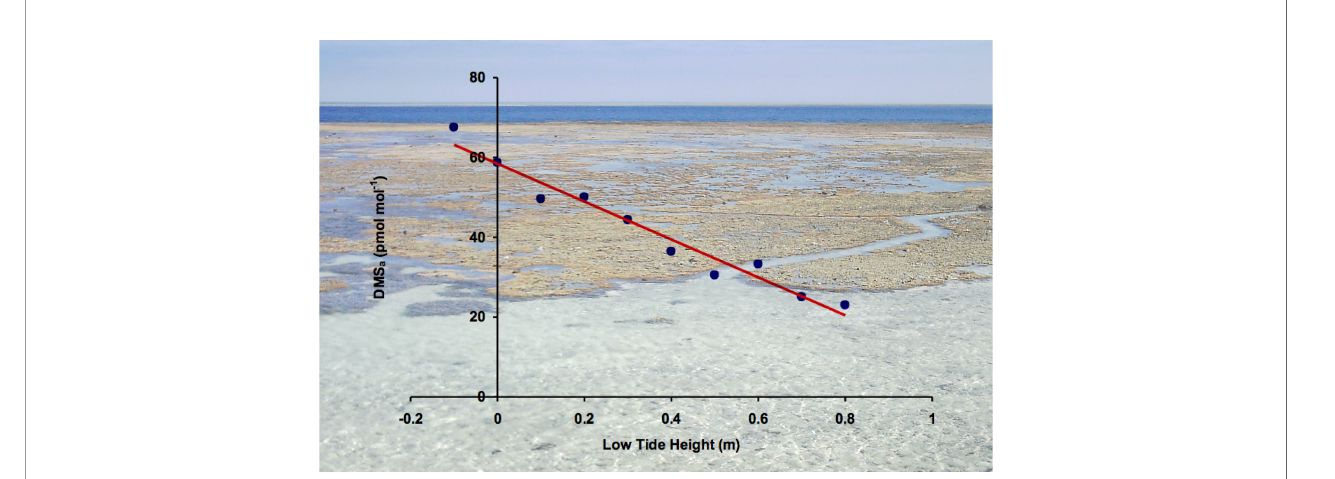
FIGURE 2 | Median atmospheric DMS mixing ratios plotted against low tide seawater height at Heron Island (23.44°S, 151.91°E) on the southern GBR, 18 Jul - 5 Aug 2013 (austral winter), derived from 30 min resolution measurements of DMS a . The plotted median values are for measurements made in a time window approximately ± 1 h either side of the low tide height range that, to varying extents, aerially exposed the 27 km 2 lagoonal platform coral reef surrounding Heron Island shown in the photo (H.B. Swan). According to the dominant south-easterly trade winds at this location, the Heron Reef and the adjacent Wistari Reef, 1 km to the south, are expected to be the sources of DMS a in excess of the approximately 20 pmol mol -1 DMS a background wintertime mixing